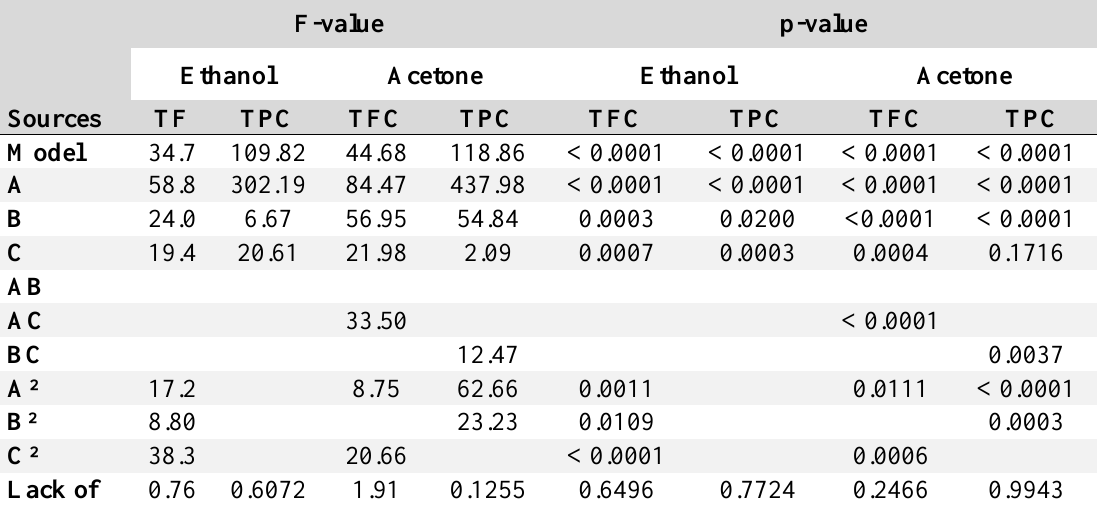
Table 3. Analysis of variance (ANOVA) results for the experiments.